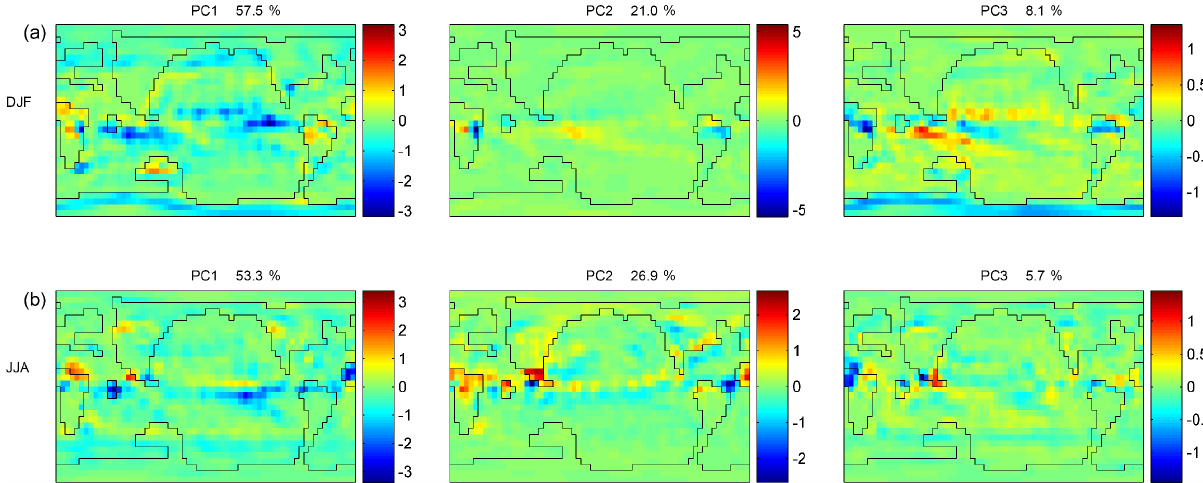
Figure 9. The first three principal components of DJF precipitation (a) and JJA precipitation (b) . Percentages of variance explained by each principal component are shown above each